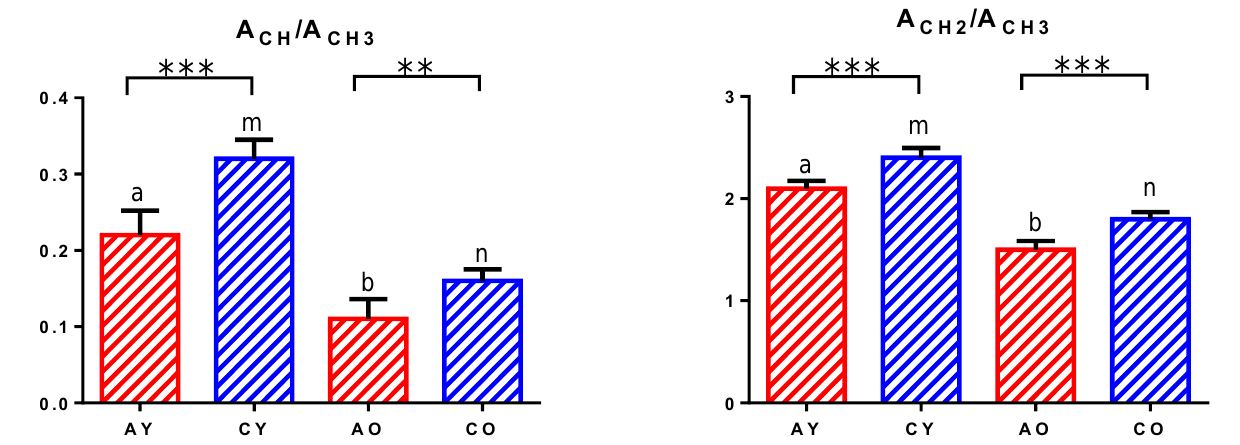
Figure 5. Statistical analysis of the lipid component of A and C regions of Young and Old CC samples: A CH /A CH3 (degree of unsaturation in lipid alkyl chains), and A CH2 /A CH3 (degree of saturation in lipid alkyl chains). Asterisks indicate statistically significant differences between A and C regions within the same group (** p < 0.01; *** p < 0.001). Different lowercase letters over histograms were used to indicate significant differences between Y and O groups ( p < 0.05).